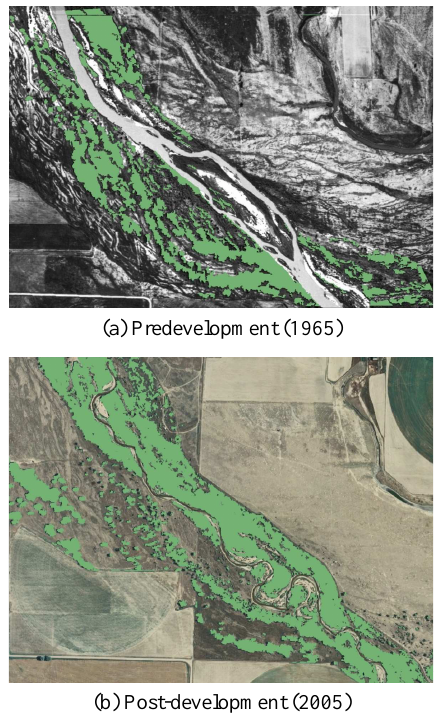
Fig. 3. An example of the multiresolution segmentation (in study site 1) used to delineate phreatophyte locations with aerial photography.